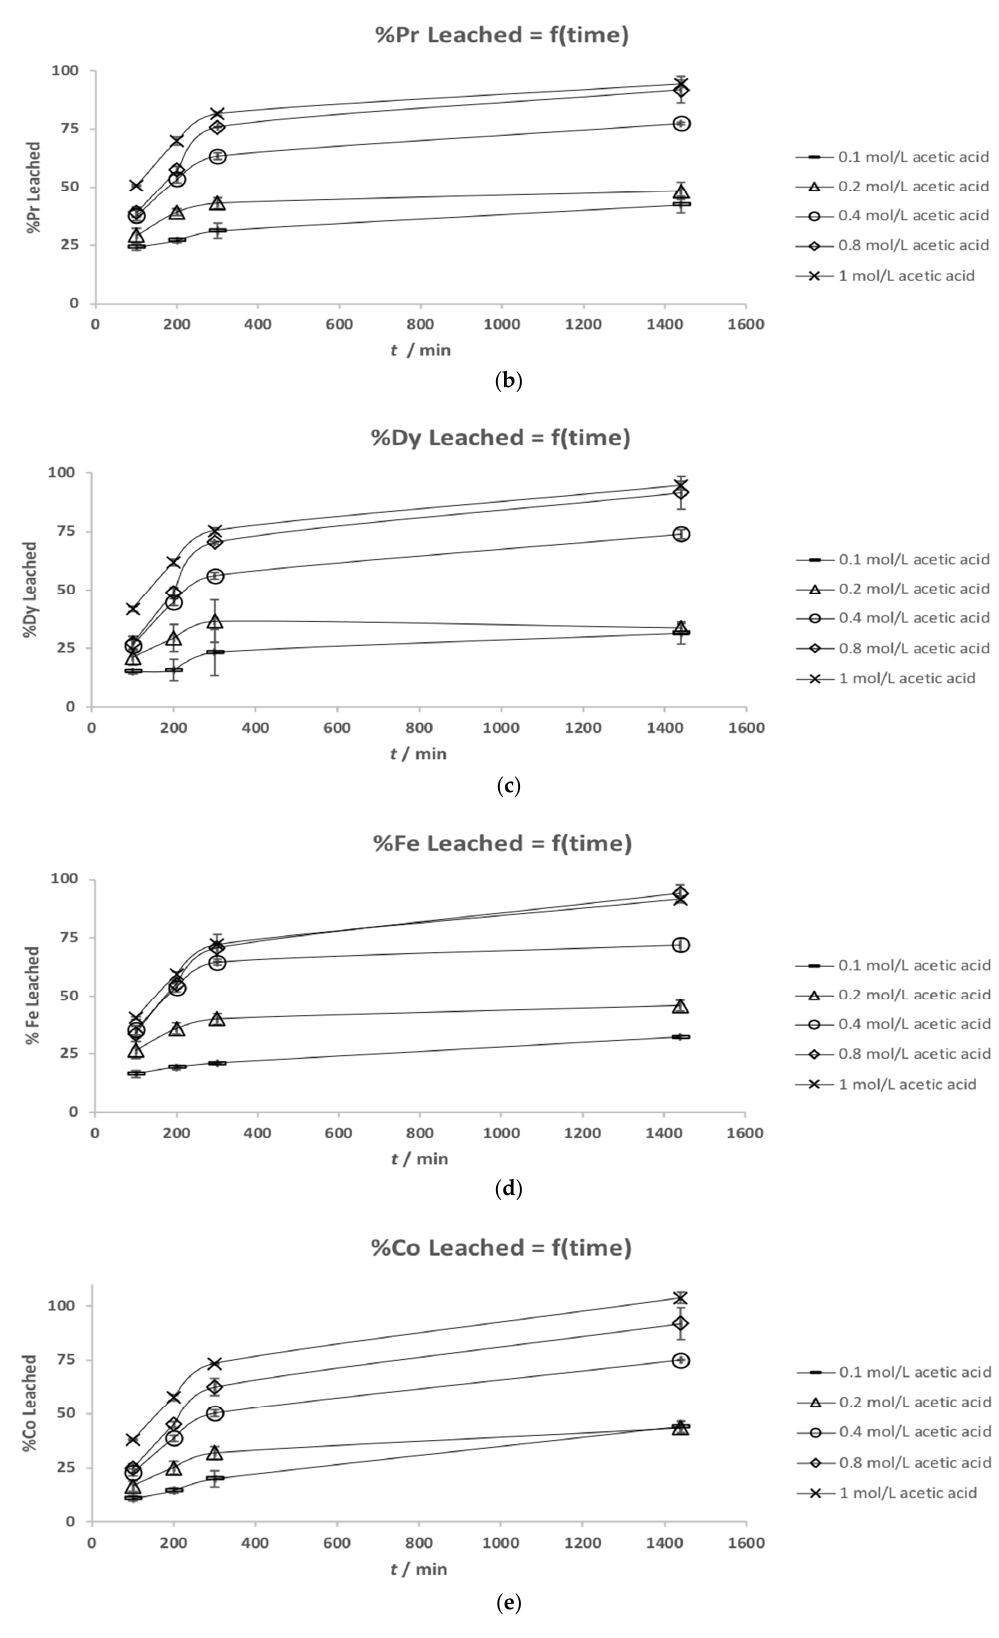
Figure 3. Effect of the concentration of acetic acid (0.1, 0.2, 0.4, 0.8 and 1 mol/L) and leaching time (100 min, 200 min, 300 min and 24 h) on the leaching efficiency of ( a ) Nd, ( b ) Pr, ( c ) Dy, ( d ) Fe, and ( e ) Co. The temperature was kept at 25 ± 1 ◦ C, magnetic stirring at 400 rpm, and S:L ratio at 1/50